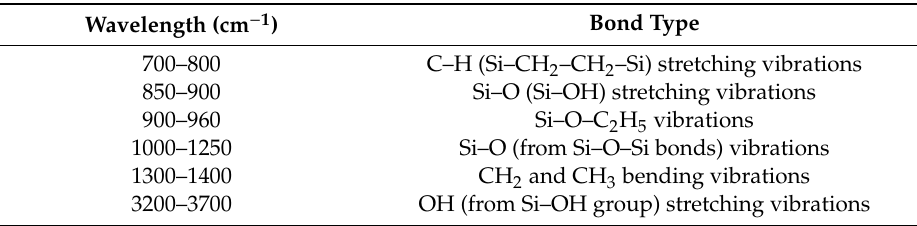
Figure 25. The alkoxide groups (Si–OCH 3 ) of KH-560 are hydrolyzed by water thereby leading to the formation of Si–OH groups and methanol. Figure 26. A condensation reaction occurs between the newly formed Si–OH groups of the coupling agent and the hydroxyl groups adsorbed on the surface of the BaTiO 3 nanoparticle. Table 5. Wavelength (cm − 1 ) and bond type found in silane films.